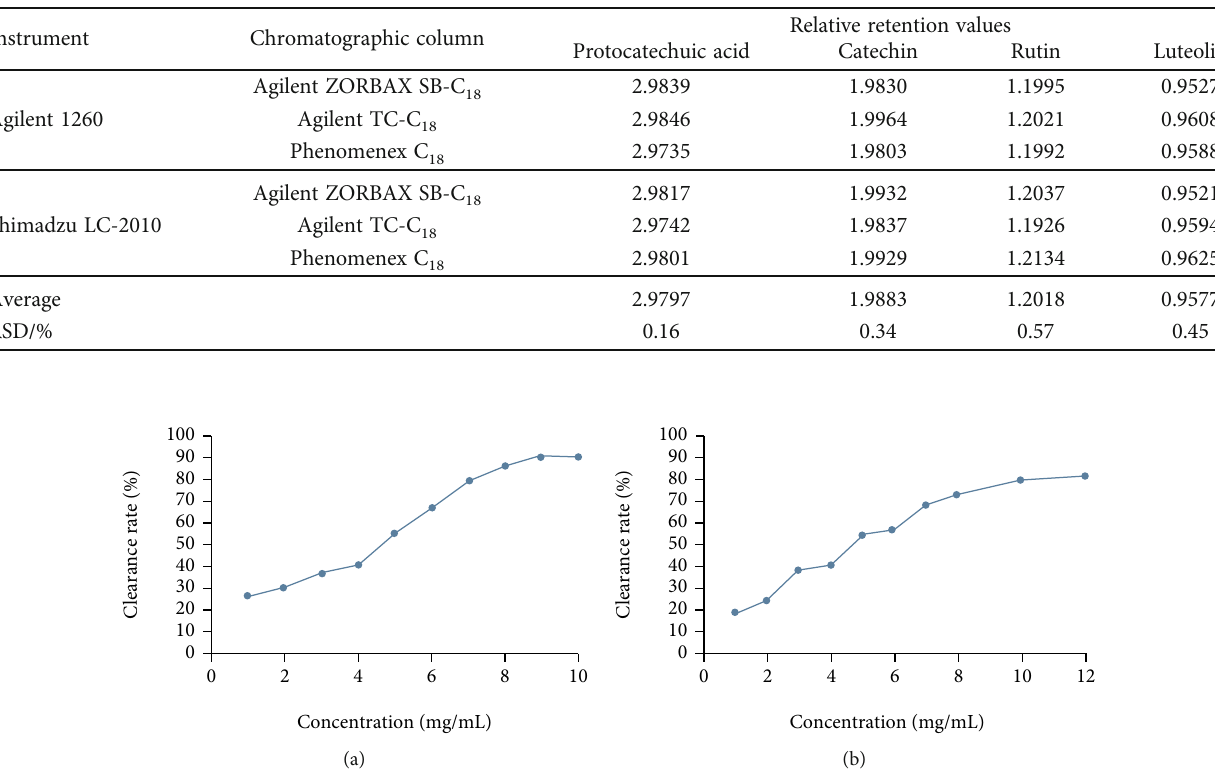
Figure 3: Clearance of DPPH · (a) and ABTS + · (b) by Hibiscus mutabilis